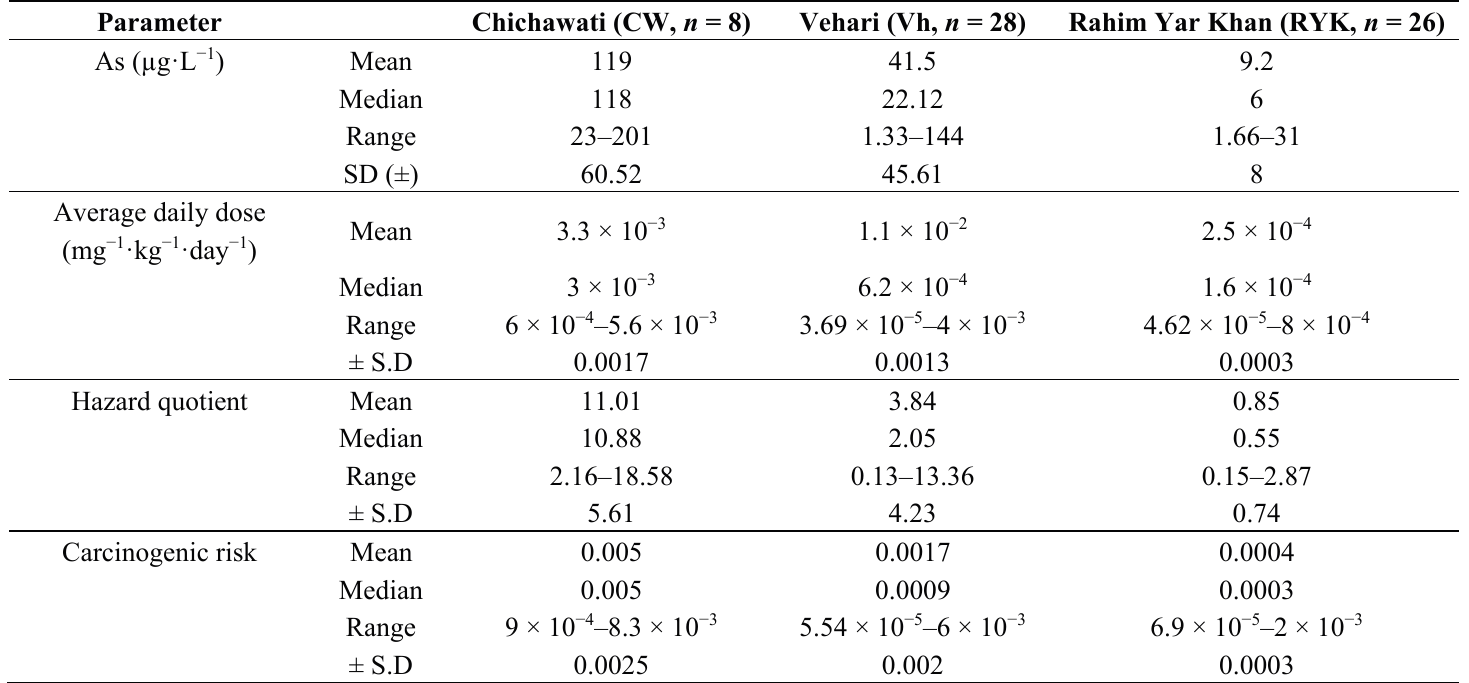
Table 4. Summary of average daily dose, hazard quotient and carcinogenic risk of As in groundwater samples collected from three rural areas of Punjab,